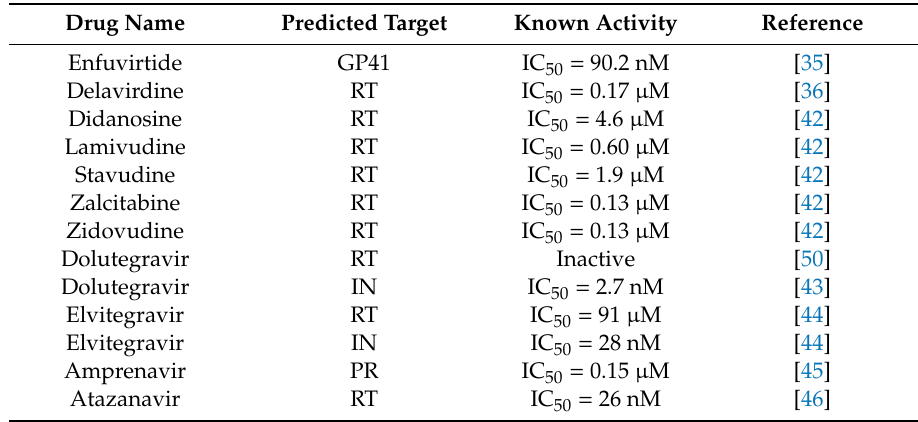
Figure 7. Polypharmacological analysis of 17 approved HIV-1 drugs and four approved HCV drugs based on the 60 multiple QSAR models generated in this study. Ellipses and octagons represent drug nodes and protein nodes, respectively. A red line indicates that the chemical–protein interaction (CPI) was experimentally verified as active. A black line indicates that the interaction was not proven to be worthy of further experimental validation. A green or yellow line indicates that the interaction was experimentally validated as inactive or inconclusive, respectively. Table 4. Known interactions among the CPIs predicted by the multiple QSAR models for approved drugs.